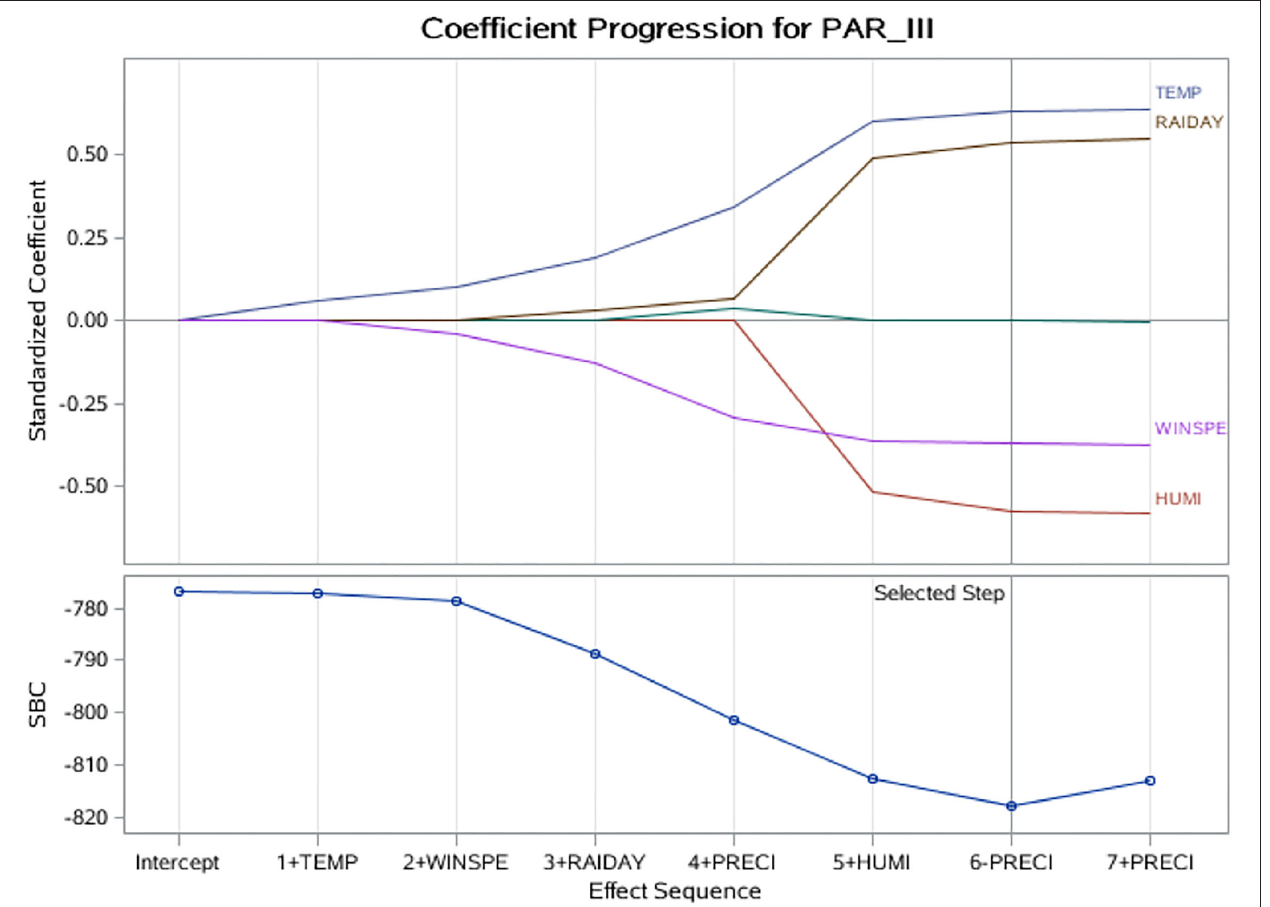
FIGURE 4 | LASSO coefficient progression plot of the HPIV-3 detection rate. HUMI, humidity; LASSO, least absolute shrinkage and selection operator; PRECI, precipitation (rainfall); RAIDAY, days of rainfall; SBC, Schwarz–Bayes criterion; TEMP, temperature; WINSPE,